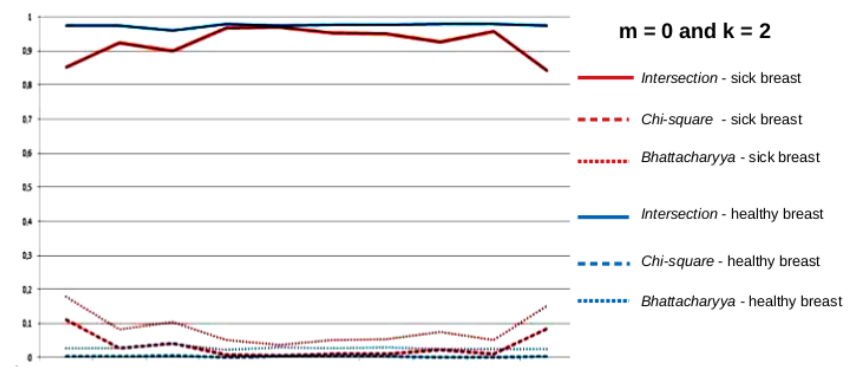
Figure 11. Time series based on the comparison of histograms, for healthy (blue) and sick (red) breasts, k = 2 and m =